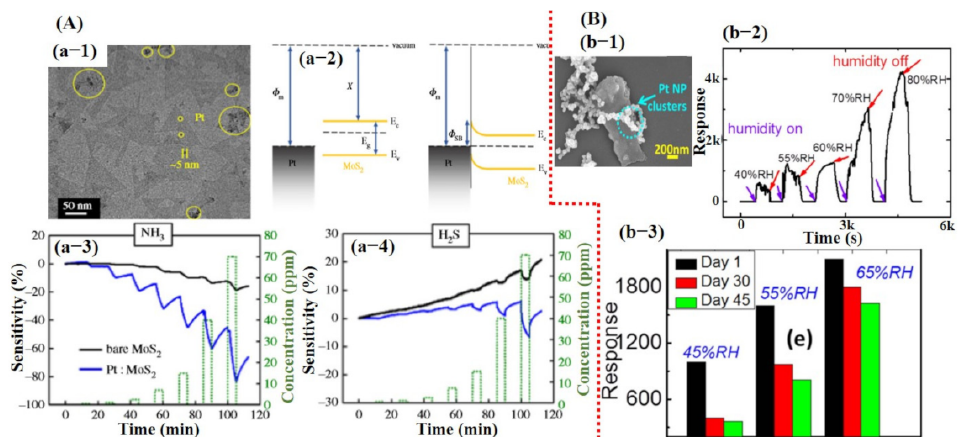
Figure 7. Demonstration of the sensing results for physically and chemically synthesized MoS 2 sheets: ( A ) Sensing properties of Pt NPs decorated on physically grown MoS 2 for NH 3 and H 2 S detection: (a-1) SEM image of monolayer MoS 2 decorated with Pt NPs. (a-2) The formation of Schottky barrier between Pt–MoS 2 and barrier height. (a-3,4) Sensor response towards the NH 3 and H 2 S. Reproduced with permission from [107], copyright 2018 Royal society. ( B ) The sensing performance of Pt NPs decorated on the chemically synthesized MoS 2 sheets towards humidity: (b-1) SEM image of Pt NPs decorated on MoS 2 . The inset reveals a higher magnified image. (b-2) Sensor response towards different levels of relative humidity. The sensor showed a good response with full recovery, revealing that a chemically synthesized MoS 2 is a promising candidate. (b-3) Stability test was checked after 1.5 months, and degradation in sensor response was observed. Reproduced with permission from [92], copyright 2018